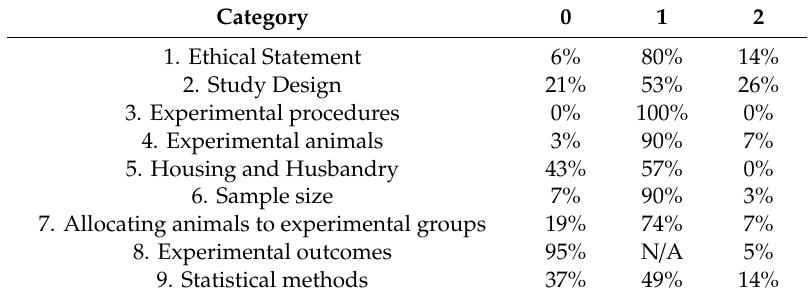
Table 1. Scores used to assess the quality of the reported methods in selected articles describing surgical procedures in pigs (based on the ARRIVE